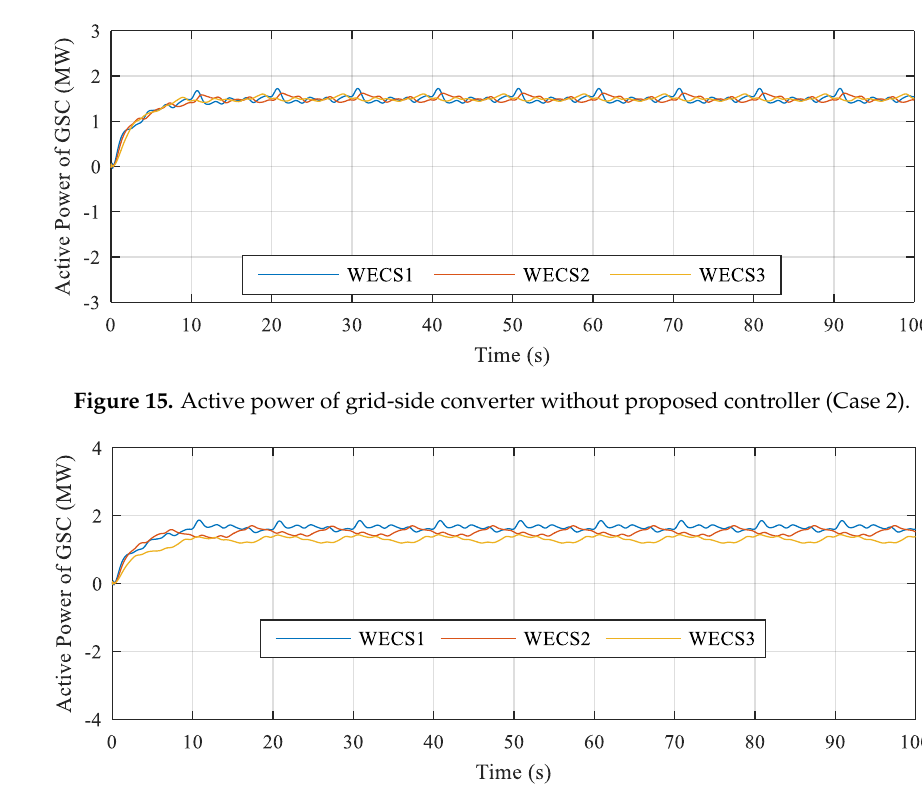
Figure 16. Active power of GSC with proposed controller (Case 2).